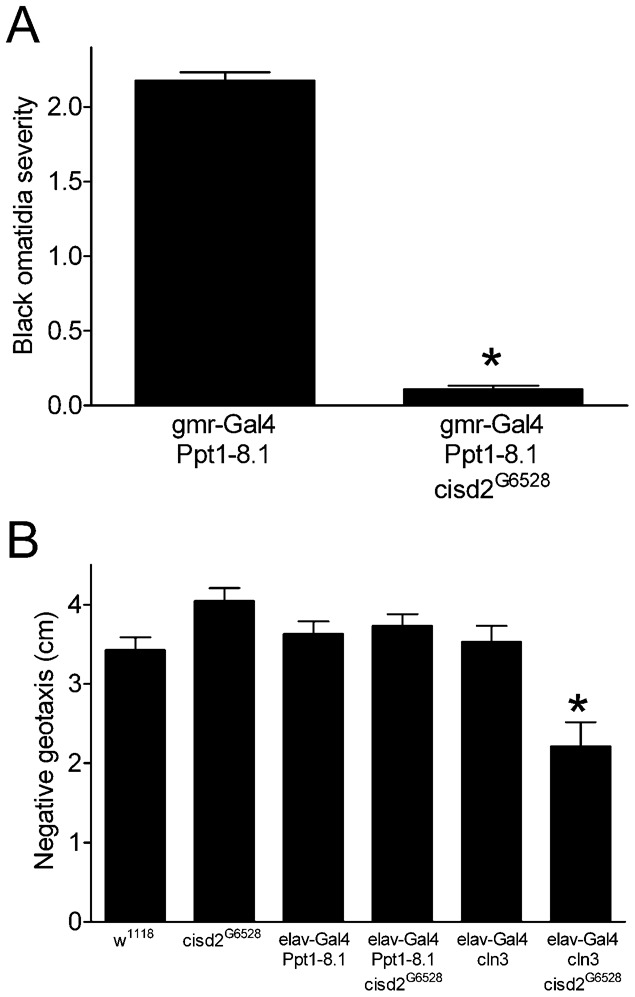
A cisd2 loss of function mutation interacts with Ppt1 and cln3 overexpression.(A) The severity of black ommatidia in flies expressing Ppt1 was reduced by the cisd2G6528 mutation (*Mann–Whitney test, p<0.0001, n = 208–237). (B) Genotype had a significant overall effect on negative geotaxis (one-way ANOVA, p<0.0001, n = 6–9). The cisd2G6528 mutation decreased negative geotaxis in flies overexpressing cln3 in the nervous system (*Bonferroni multiple comparison, p<0.001).